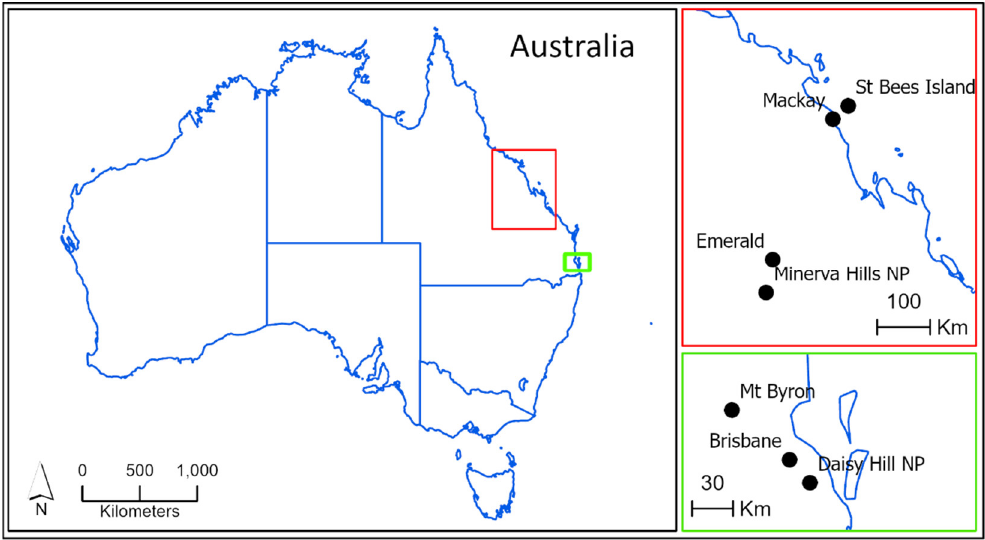
Figure 1. Fieldwork locations: red rectangle, field locations in central Queensland; green rectangle, field locations in South-east Queensland.